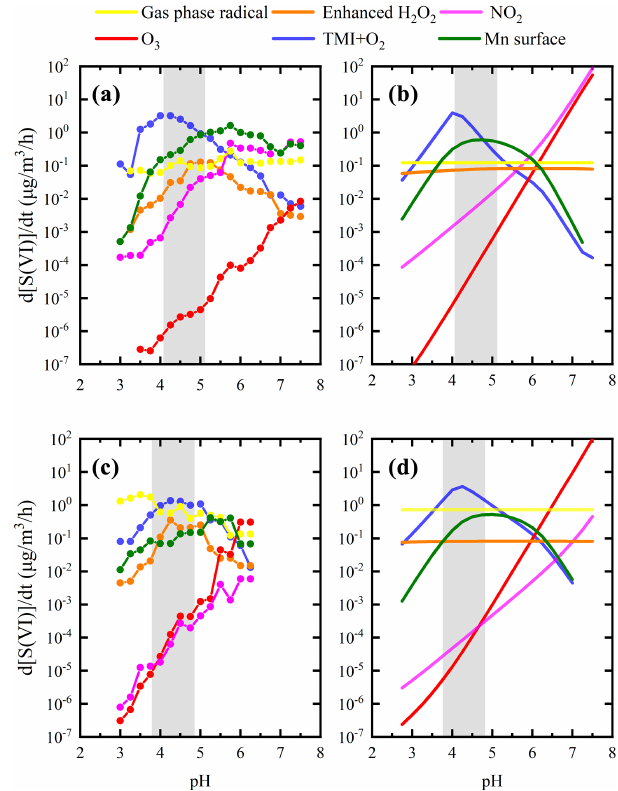
Figure 2. Multiphase sulfate production under actual ambient con- ditions (a, c) and averaged conditions (b, d) in winter (a, b) and summer (c, d) in the North China Plain. Given the actual measured concentration, the steady-state concentration of each reactant was calculated using the PKU-MARK model, accounting for the impact of ionic strength on the Henry’s law coefficient of the gas-phase re- actants. Panels (a) and (c) show the cluster-averaged results with a pH span of 0.5. Panels (b) and (d) show the sulfate formation rate obtained by fixing the average precursors levels during the haze pe- riods and by changing the aerosol pH, which is consistent with the calculation method of previous studies (Cheng et al., 2016). Grey- shaded areas indicate the ISORROPIA II (Fountoukis and Nenes, 2007) model calculated pH ranges during the haze periods of two field campaigns. The solid colored lines represent sulfate production rates calculated for different multiphase reaction pathways with ox- idants: enhanced H 2 O 2 , O 3 , TMIs, NO 2 , surface Mn and gas-phase radicals (OH + SCIs). The solid orange line represents the calculated sulfate formation rate via H 2 O 2 with a factor of 100 in winter and summer according to the latest research results (T. Liu et al., 2020). Reactant concentrations, aqueous reaction rate expressions and rate coefficients are summarized in the